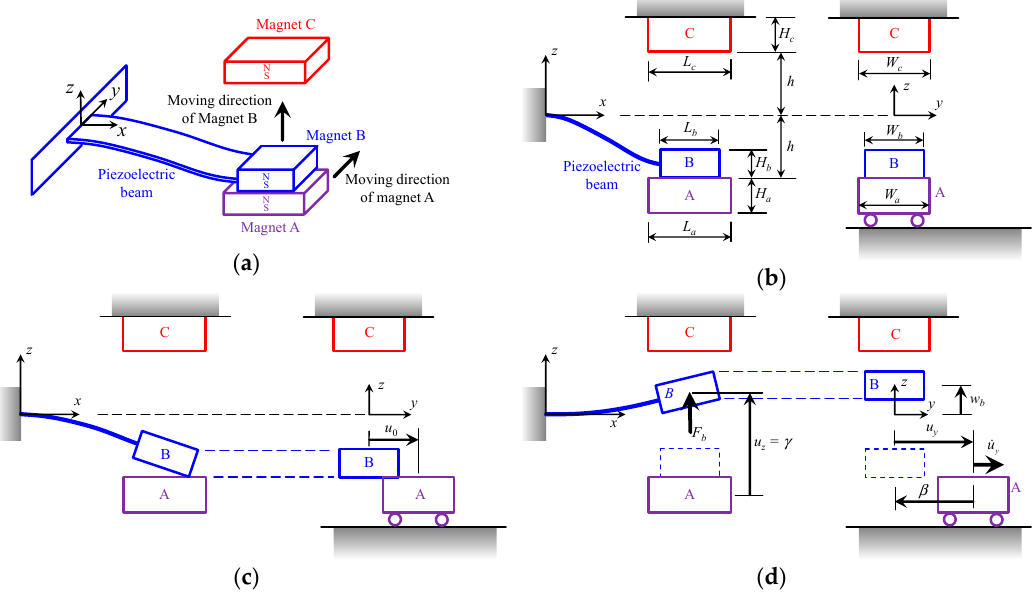
Figure 1. The conceptual drawing of the piezoelectric energy harvester (PEH). ( a ) The iso-view of the PEH at the initial status; ( b ) The side view and front view of the PEH at the initial status; ( c ) The PEH at the time that magnet B separates from magnet A; ( d ) The beam deflection before impact.